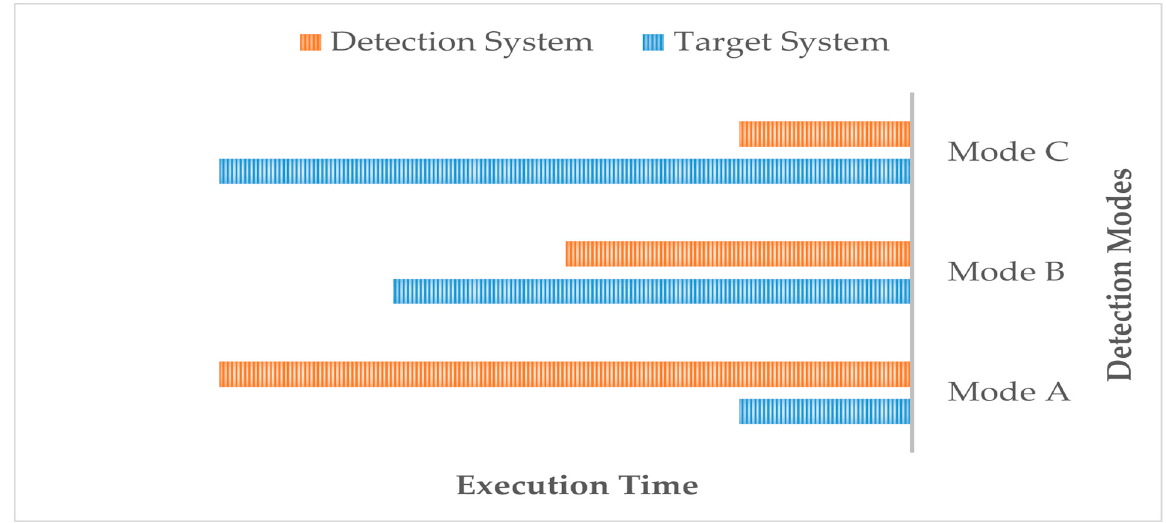
Figure 10. Target system performance speed vs. detection system response speed among detection modes.